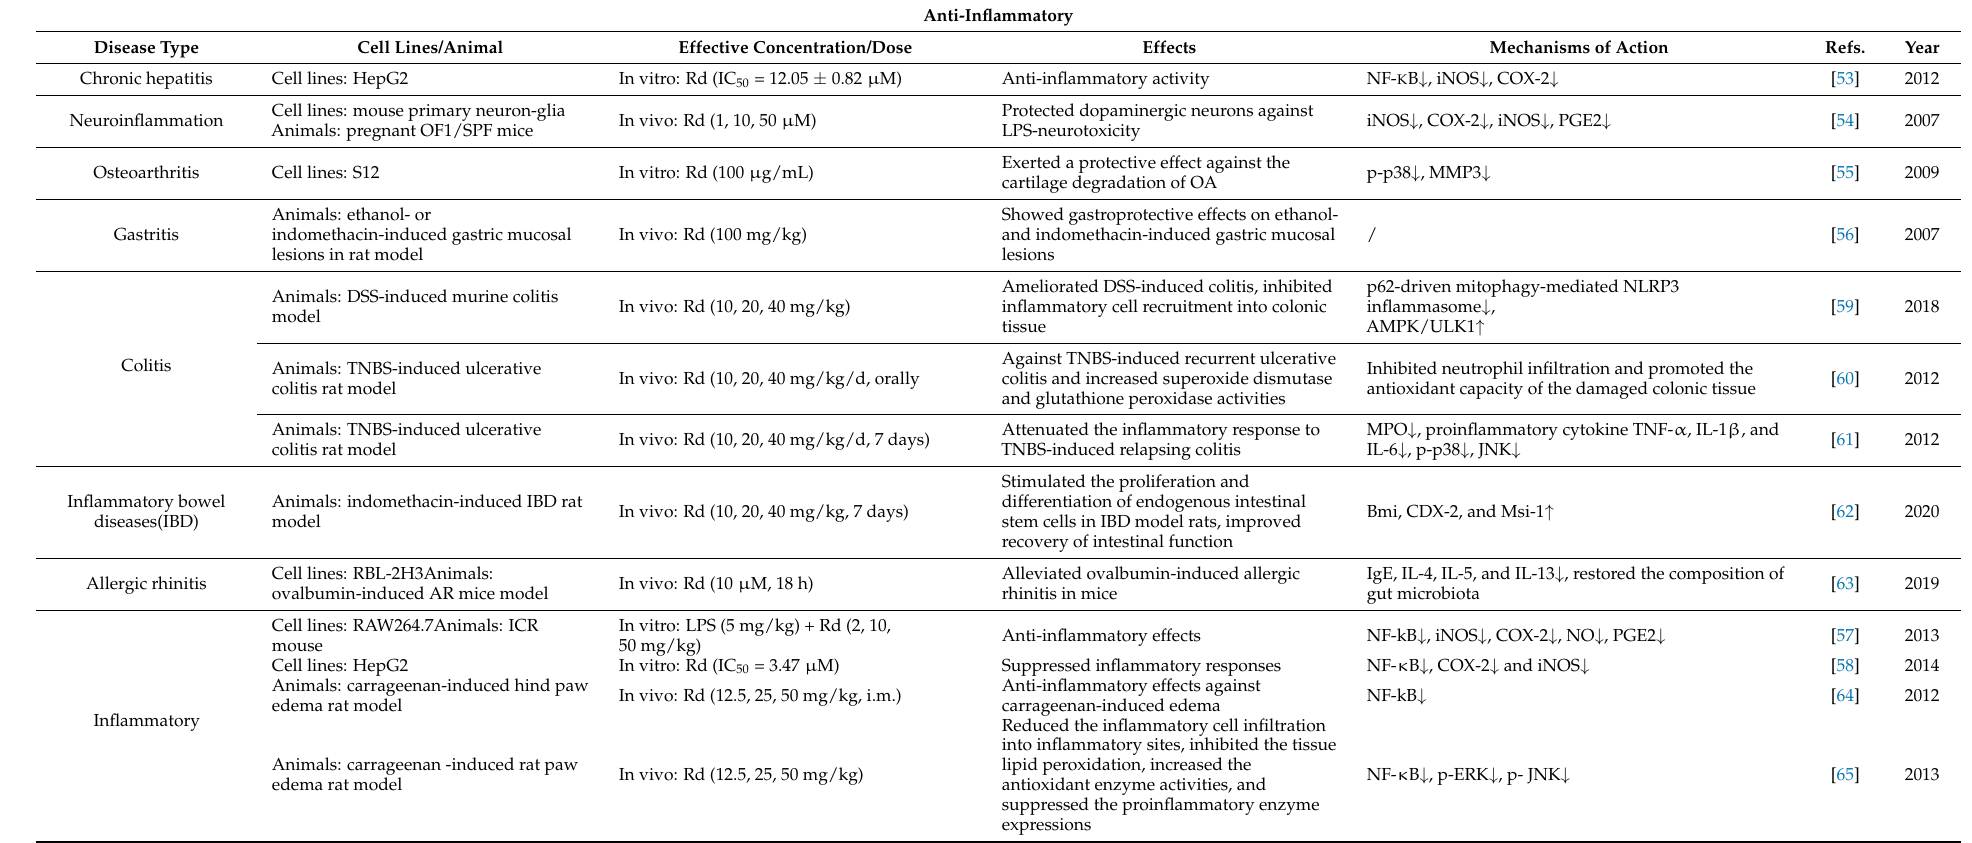
Table 3. Anti-inflammatory and antioxidative effects and the molecular mechanisms of